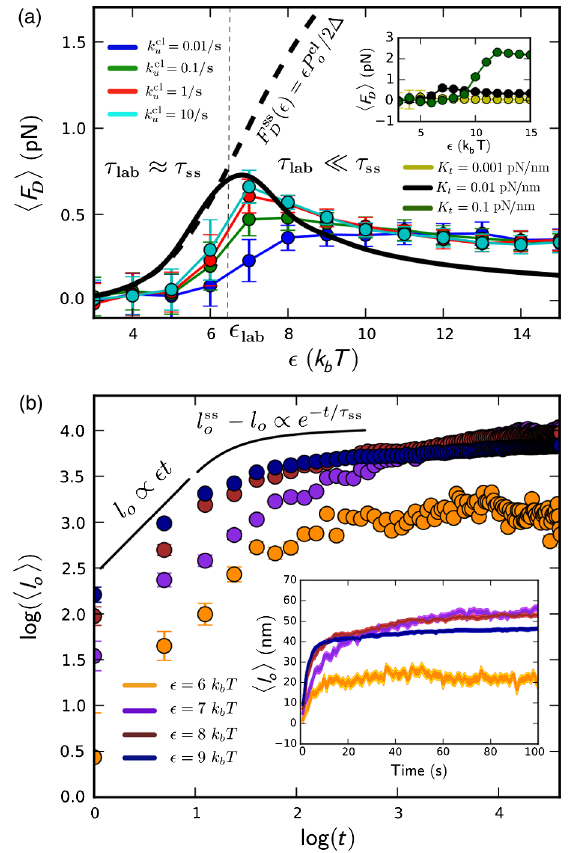
FIG. 3. Cross-linker driven contraction of the passive force i at τ ¼ 200 s dipole in one dimension. (a) Average force h F D lab ¼ 0 . 01 pN = nm, as a function of cross-linker binding for K t energy ϵ . The analytically predicted F ss according to the D thermodynamic limit in Eq. (7) is shown as the black dotted curve, with the numerical solution to Eq. (6) as solid black; these ≈ 6 k T . This corresponds to the tran- solutions diverge at ϵ b lab ≪ τ sition τ caused by increasing binding strength of cross- lab ss links. Increasing speed of unbinding shifts curves to the predicted thermodynamic limit. The inset displays stochastic trajectories for the same cross-linker binding energies. (b) Log-log plot of the i vs time for ϵ values around ϵ average filament overlap h l o lab ∝ ϵ t= ð 1 þ ve − ϵ =k b T Þ shows a linear force-generating regime l o followed by an exponential relaxation to steady state: − l ∝ e − t= τ ss , with τ ∝ ð 1 þ v − 1 e ϵ =k b T Þ l o = Δ . Trajectories l ss o o ss ¼ 200 s, as shown above ϵ are far from equilibrium at τ lab lab by a significant flattening of the l vs t curve at long times for o increasing binding